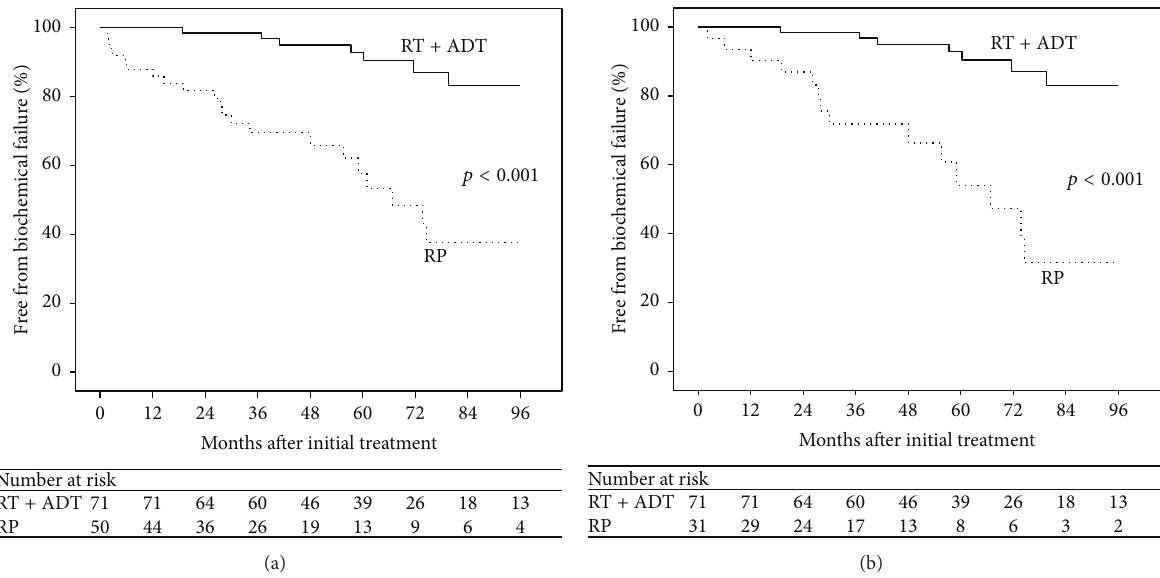
Figure 2: Kaplan-Meier estimate of freedom from BF in RT + ADT and RP patients with GS ≥ 8 on biopsy or pathology (a) and patients with GS ≥ 8 on biopsy